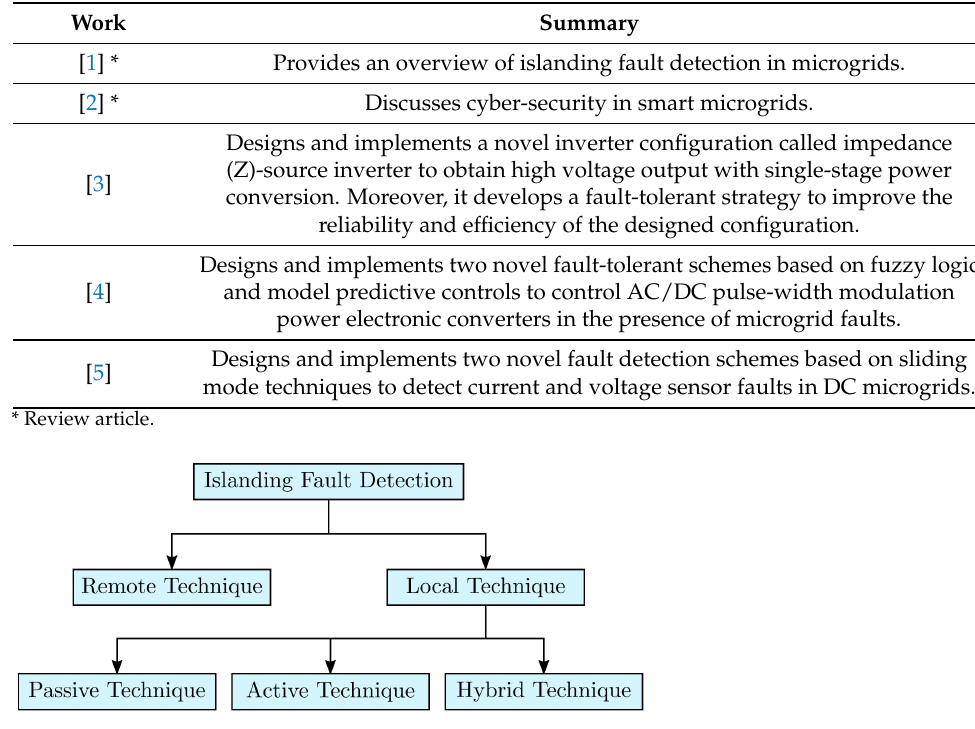
Figure 1. Islanding fault-detection techniques